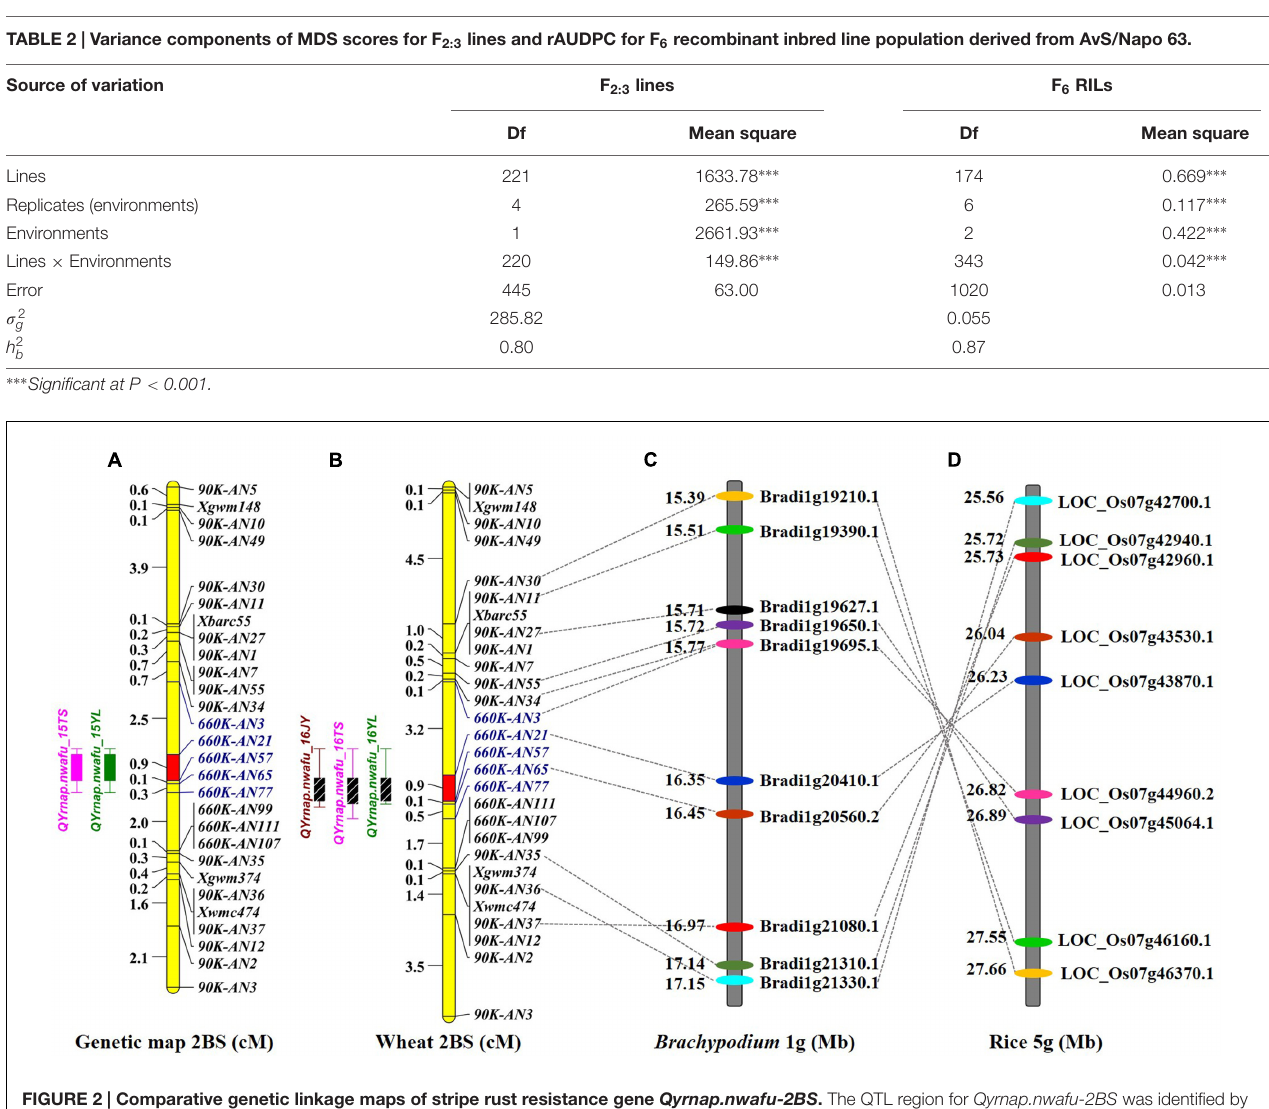
FIGURE 2 | Comparative genetic linkage maps of stripe rust resistance gene Qyrnap.nwafu-2BS . The QTL region for Qyrnap.nwafu-2BS was identified by QTL mapping using phenotypic and marker data from AvS × Napo 63. (A) Genetic linkage maps of Qyrnap.nwafu-2BS on chromosome 2BS produced from results of by using F 2 : 3 lines (A) and F 2 : 6 RILs (B) . (C,D) Orthologous genomic regions of Qyrnap.nwafu-2BS on Brachypodium chromosome 1 and rice chromosome 5.